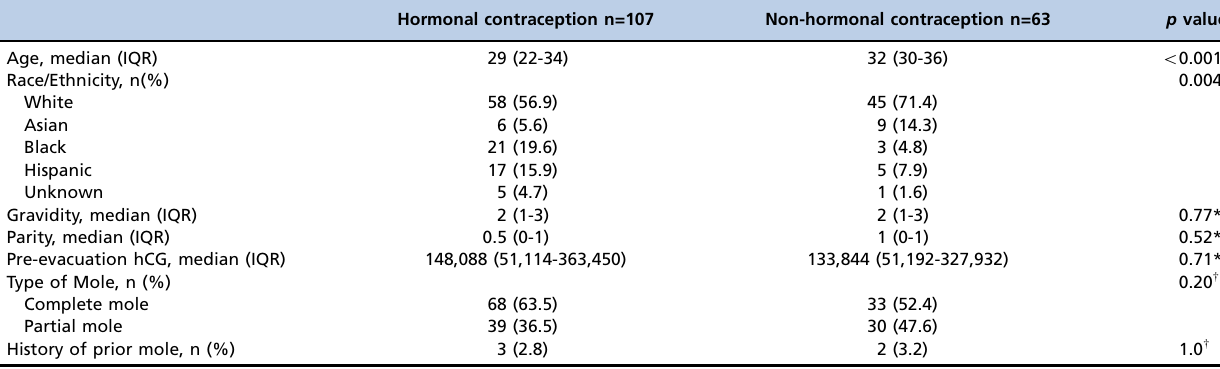
Table S7 - Characteristics of women with hydatidiform molar pregnancies by contraception type.